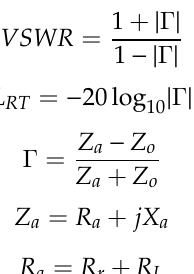
Figure 8. Measurement setup ( a ) Proposed antenna in the anechoic chamber; ( b ) Zoom in view.